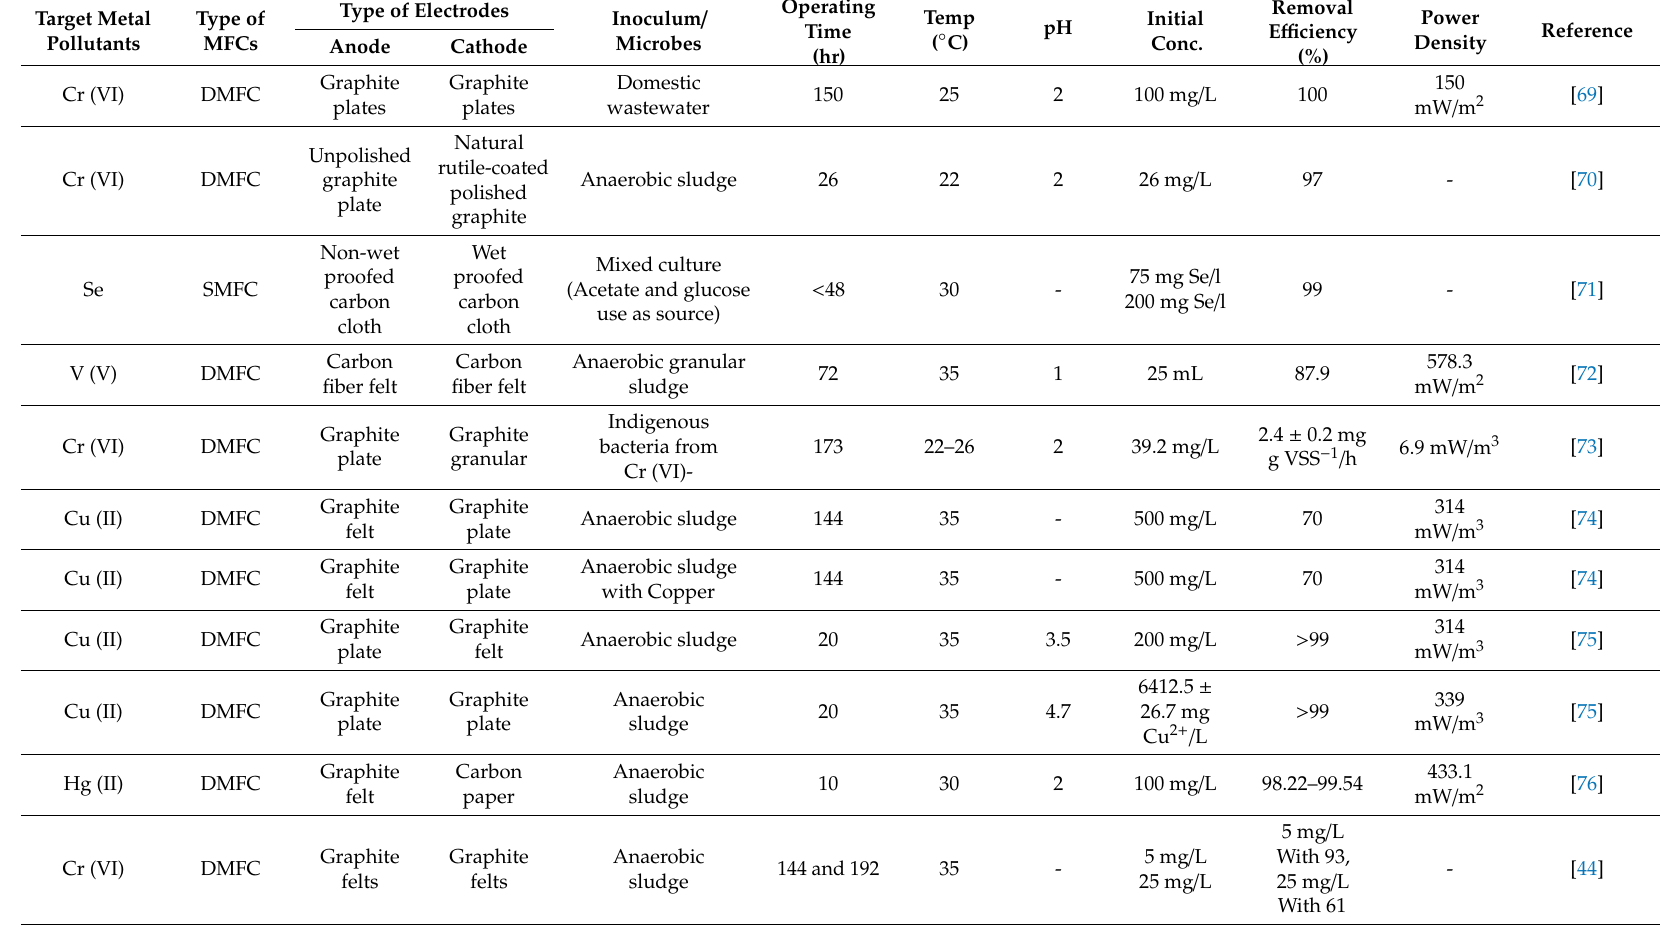
Table 1. Degradation of toxic metals with their energy outputs through